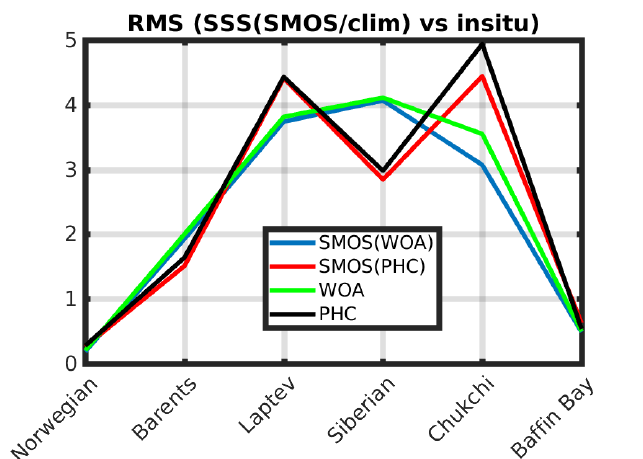
Figure 2. Assessment of the impact associated to the choice of the annual climatology in the SMOS SSS product generation. The blue line corresponds to the root mean square (RMS) of the differences between SMOS SSS derived with WOA annual mean and the TARA SSS; the red line corresponds to the RMS of the differences between SMOS SSS derived with PHC annual mean and TARA SSS; and the green (black) line represents the RMS differences between WOA (PHC) SSS and TARA SSS.